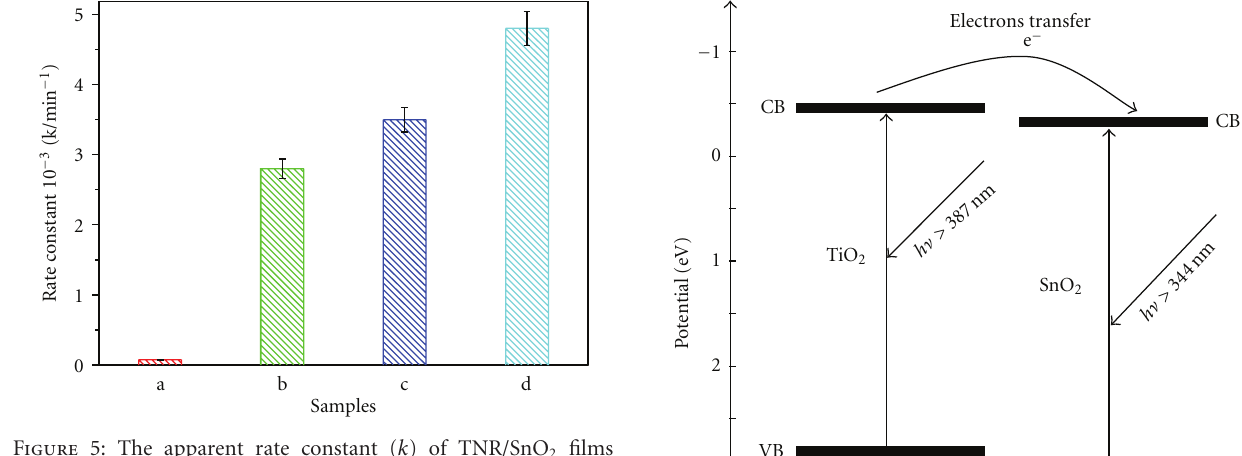
Figure 5: The apparent rate constant ( k ) of TNR/SnO 2 films calcined for 2 h at (a) 300, (b) 400, (c) 500, and (d) 600 ◦ C.